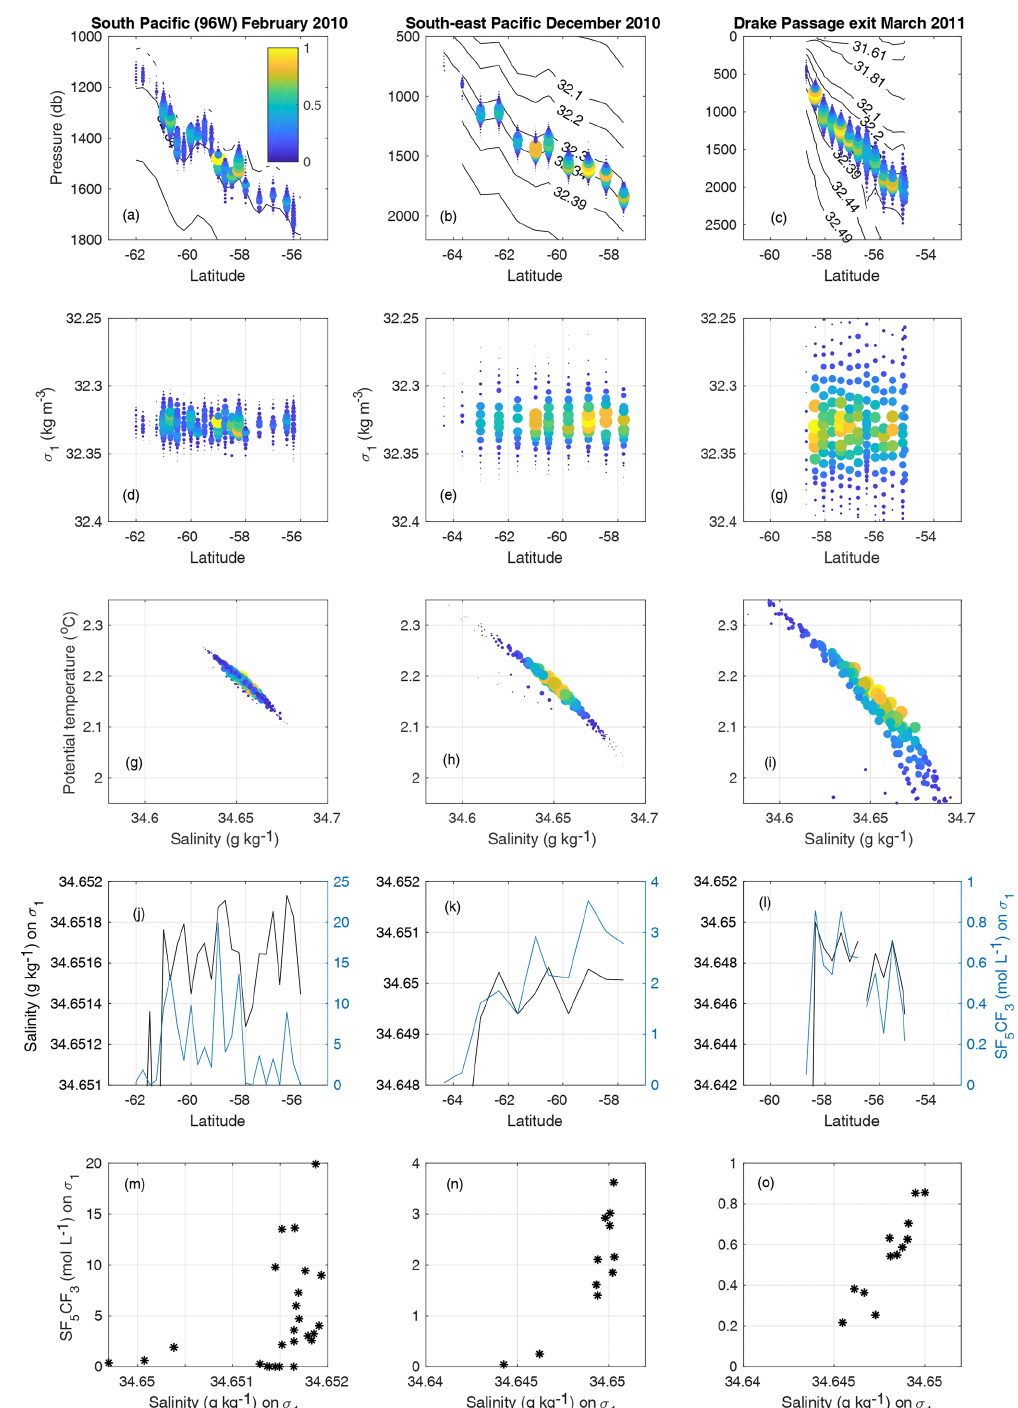
Figure 3. (a–c) Depth and latitude of tracer measurements, with contours of potential density referenced to 1000m ( σ 0 ; not evenly spaced). The Polar Front and the Subantarctic Front are where the slope of the density surfaces is large, near the southern and northern ends of these sections. (d–f) Potential density and latitude of tracer measurements. (g–i) Potential temperature and salinity. (j–l) Salinity and tracer on the σ 1 = 32 . 325kgm − 3 surface. (m–o) Scatter plot of salinity and tracer concentration on the σ 1 = 32 . 325kgm − 3 surface (note the changing y axis range). For panels (a) – (i) , colour represents tracer concentration relative to the peak measured for that section. Panels (a) , (d) and (g) are from the South Pacific cruise of February 2010; (b) , (e) and (h) the south-east Pacific section of December 2010; (c) , (f) and (i) the Drake exit section of March